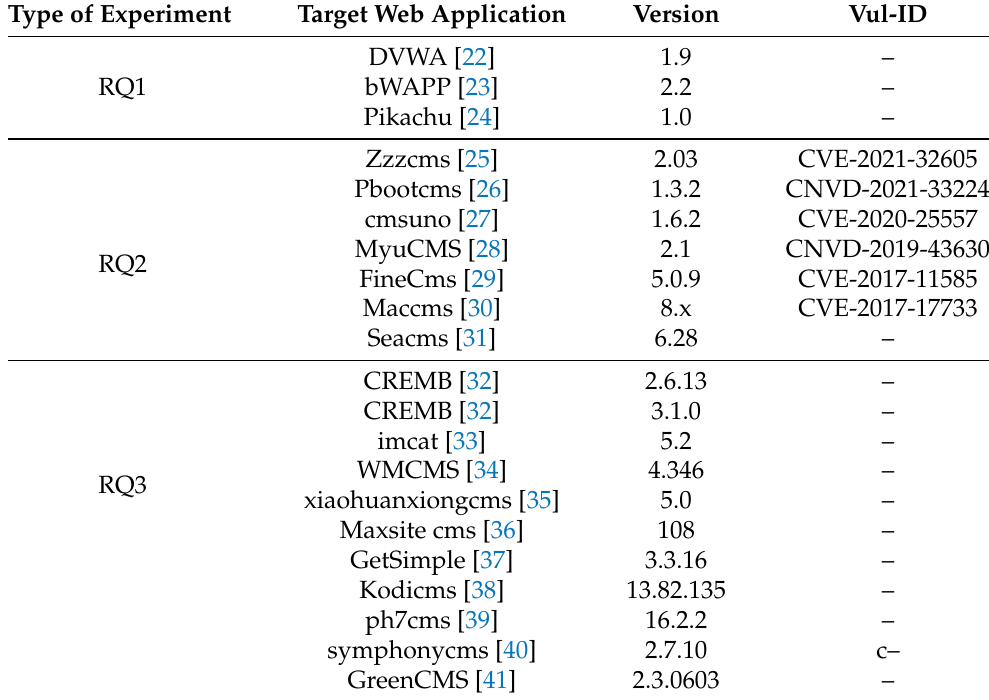
Table 1 . Experimental data